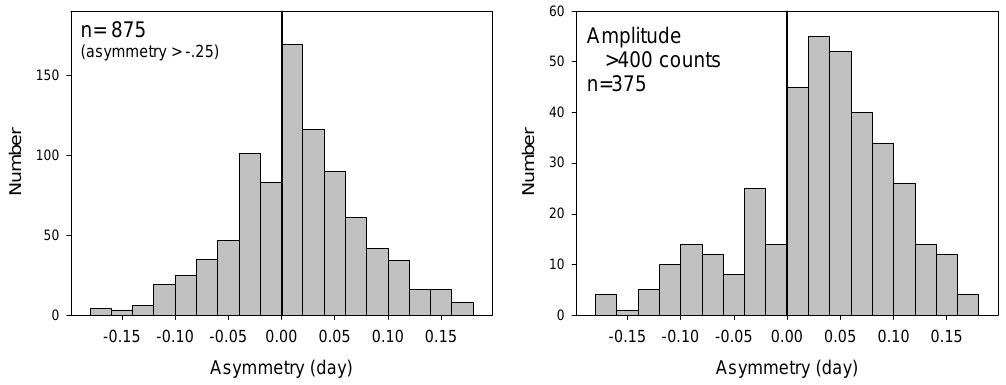
Figure 9: Peak symmetry distribution (Left) indicating the overall faster change of the decreasing limb. The peak symmetry is calculated as the difference of width at half peak height between a decreasing flank symmetric to the rising flank and the actually decreasing flank (see Fig.10). This incidence of asymmetry is emphasized when considering the relatively intense peaks (Right). decreasing limb was modified by adding a correction based on the radioactive decay of radon from peak-time (indicated). As shown, correcting for the decay of radon does not allevi- ate this